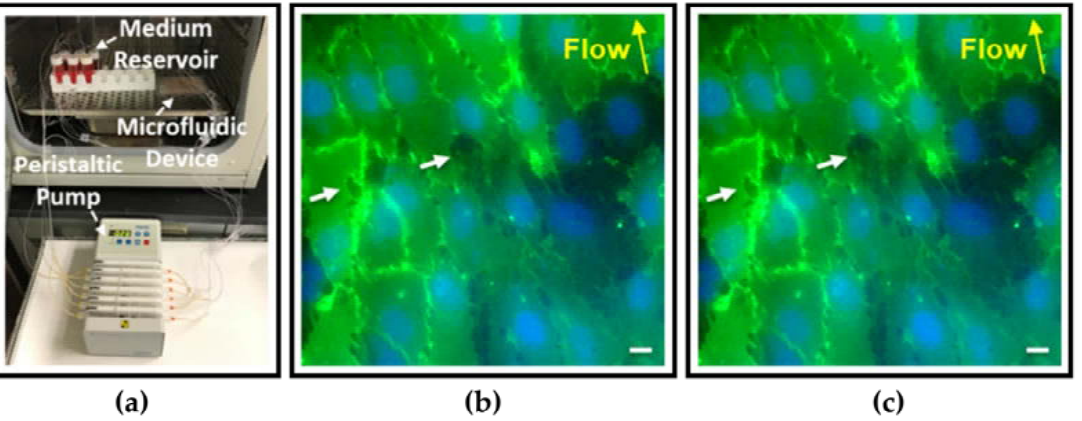
Figure 5. ( a ) A microfluidic device that mimics the circulation of MM cells through the BM sinusoidal endothelium [138], Copyright 2022, Scientific Reports. ( b , c ) Endothelial layer formed after 30 h of culture CD31 (green) and DAPI (blue). White arrows show pores, yellow arrows show the direction of flow adopted from [138], Copyright 2022, Scientific Reports.